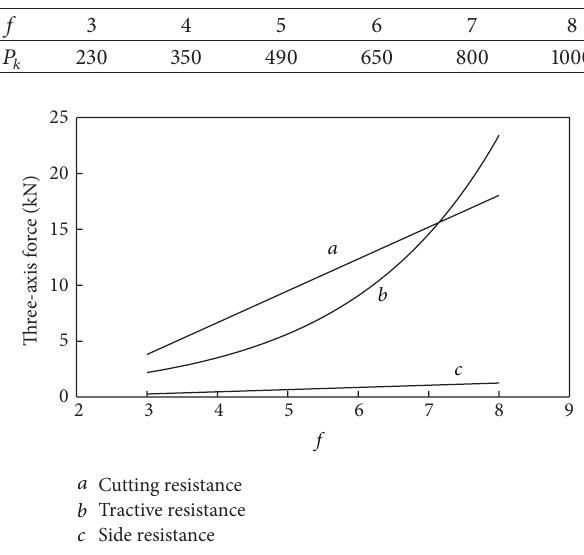
Table 1: Corresponding relationship between 𝑃 𝑘 and 𝑓 .